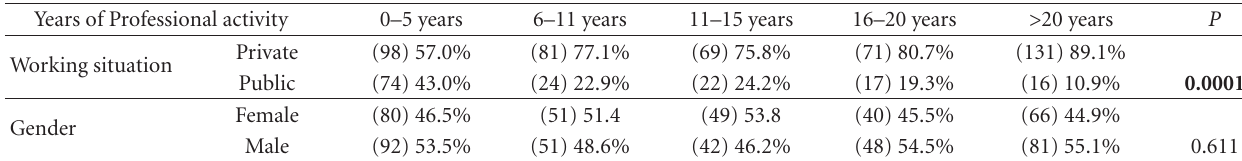
Table 1: Working situation and gender according to years of professional experience.